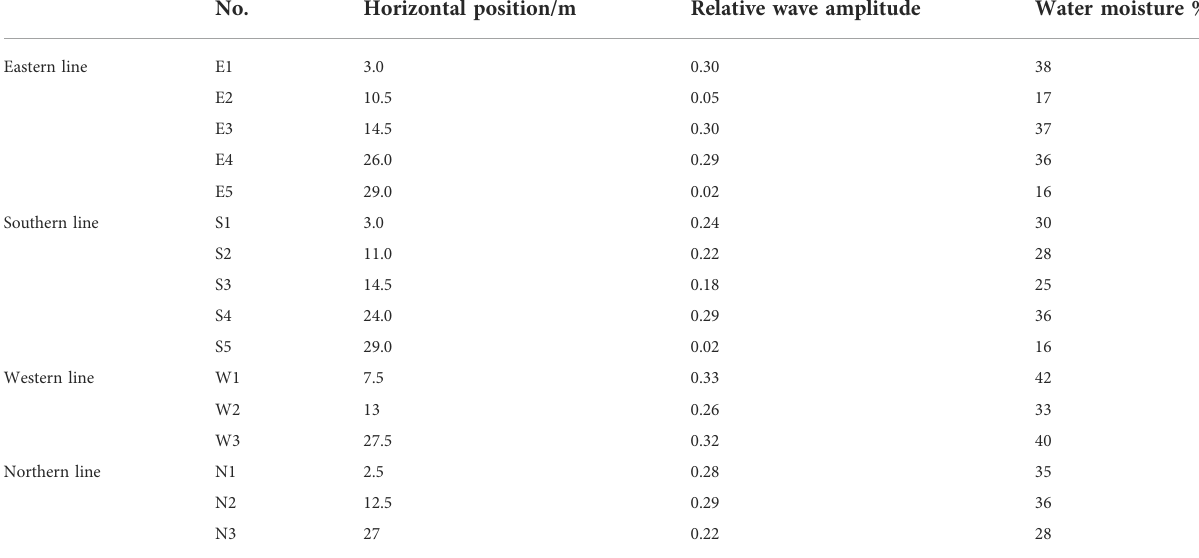
TABLE 5 Summary of defects and quanti fi cation of water moisture of the foundation. No. Horizontal position/m Relative wave